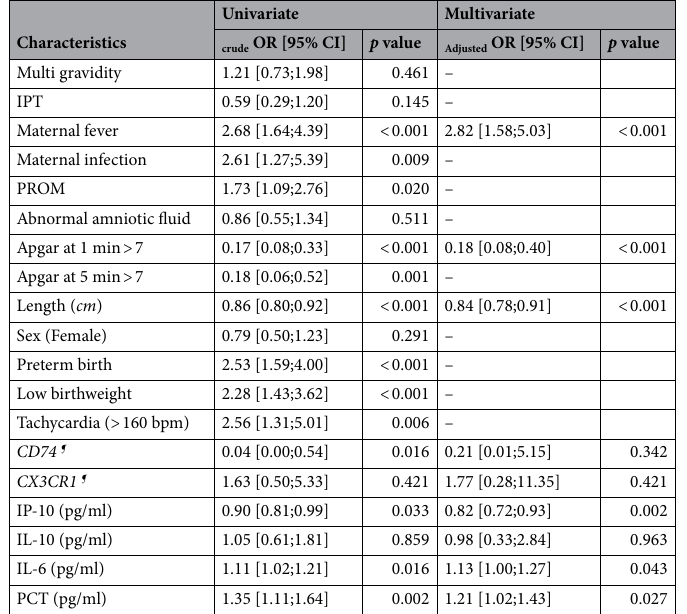
Table 5. Factors associated with clinical sepsis using univariate and multivariate logistic regression models. IPT, intermittent preventive treatment against malaria; CD74 , HLA class II histocompatibility antigen gamma chain; CX3CR1; CX3C chemokine receptor 1; IL , Interleukin; PCT, procalcitonin. ¶ CD74 and CX3CR1 are expressed as relative expression to